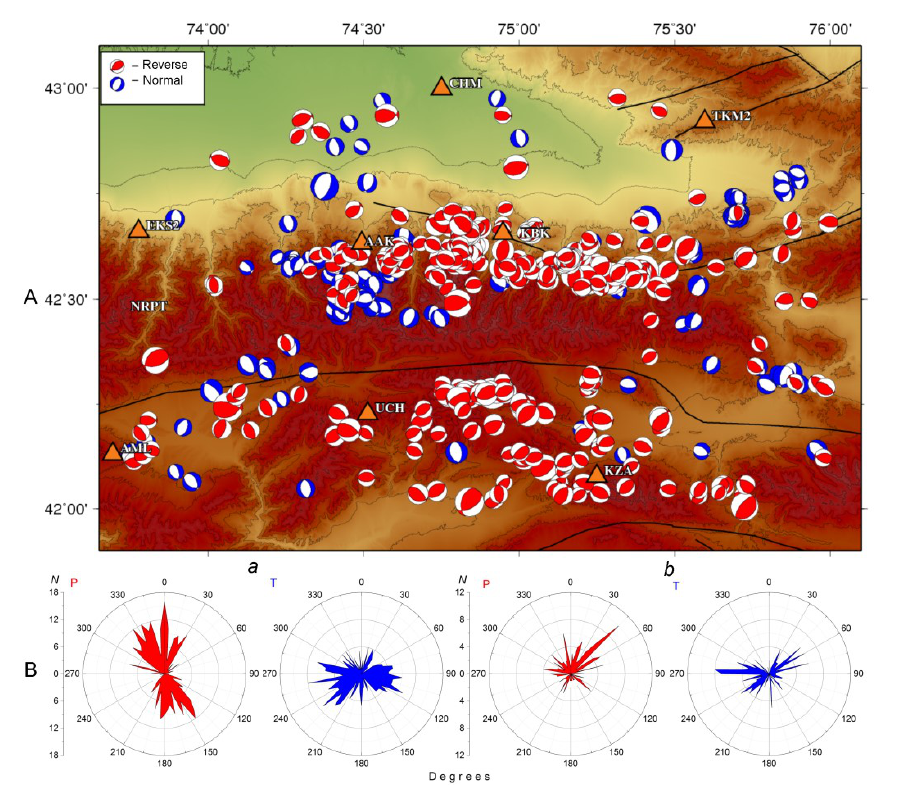
Fig. 5 . A - the earthquakes position of the reverse fault and normal fault types.  - KNET stations. B - diagrams of the distribution of the azimuths of the compression ( P ) and tension ( T ) axes for the mechanisms of reverse fault events ( a , 345 events) and normal fault events ( b , 141 events).